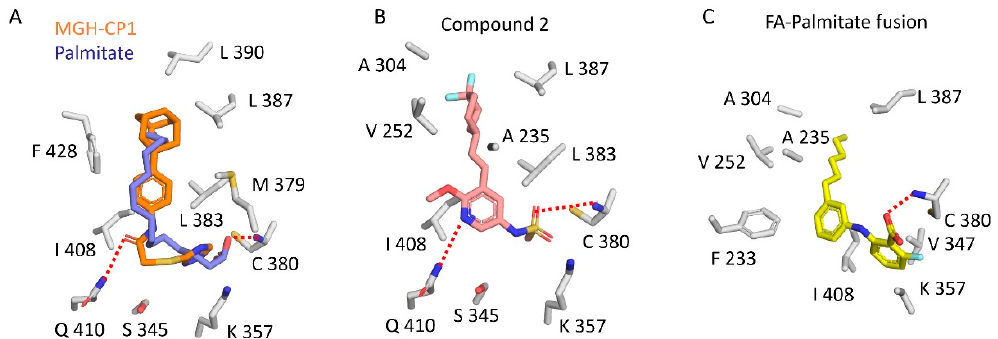
Figure 3. Small molecules that occupy the central pocket of TEAD2. Crystal structures showing the conformations of palmitate and MGH-CP1 ( A ), compound 2 ( B ), and FA-Palmitate fusion compound ( C ) in the central pocket of TEAD2. PDB IDs: 5HGU (Palmitate), 6CDY (MGH-CP1), 6UYC (compound 2 ), 6VAH (FA-Palmitate fusion). The side chains of residues that surround these ligands are shown as grey sticks, putative hydrogen bonds are shown as dashed red lines.